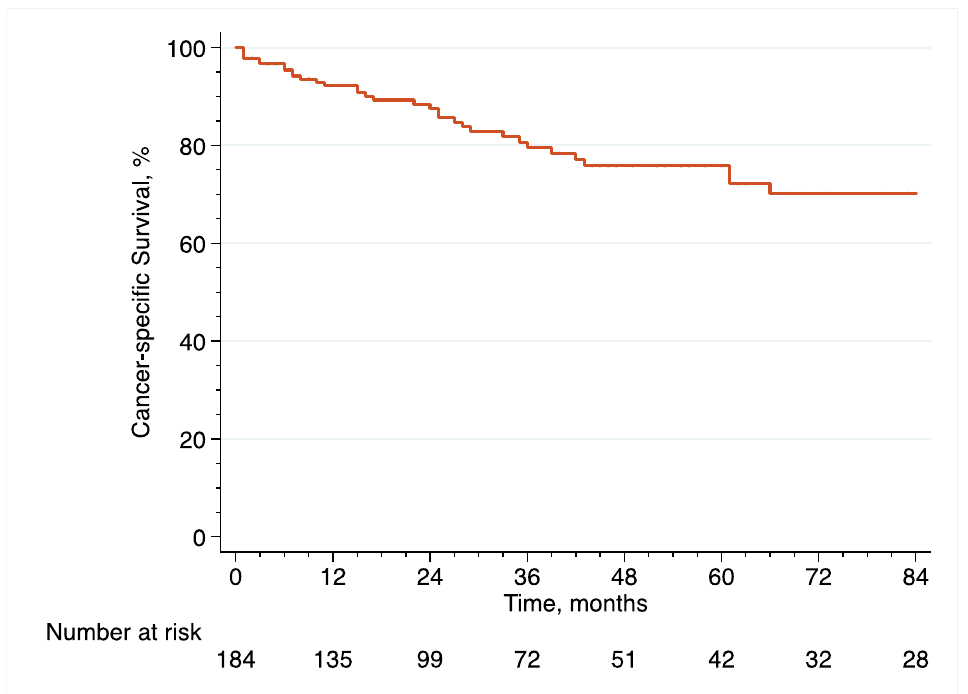
Figure 1. Kaplan–Meier curve that analyses the RFS of included patients treated with eRC for HR- NMIBC.